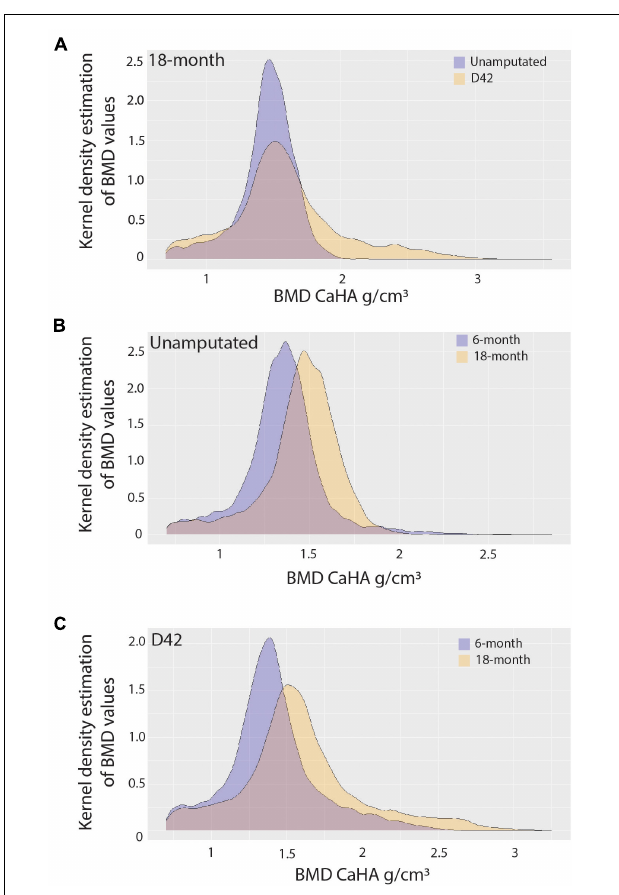
FIGURE 2 | Bone mineralization. Pooled kernel density estimates compare (A) 18-month-old unamputated and regenerated digits, (B) 6-month-old and 18-month-old unamputated digits, and (C) 6-month-old and 18-month-old regenerated digits, showing the probability (frequency), and spread (density value range) of density values. Best-fit curve with normal distribution (significantly different p < 0.001). N = 10–12 digits.